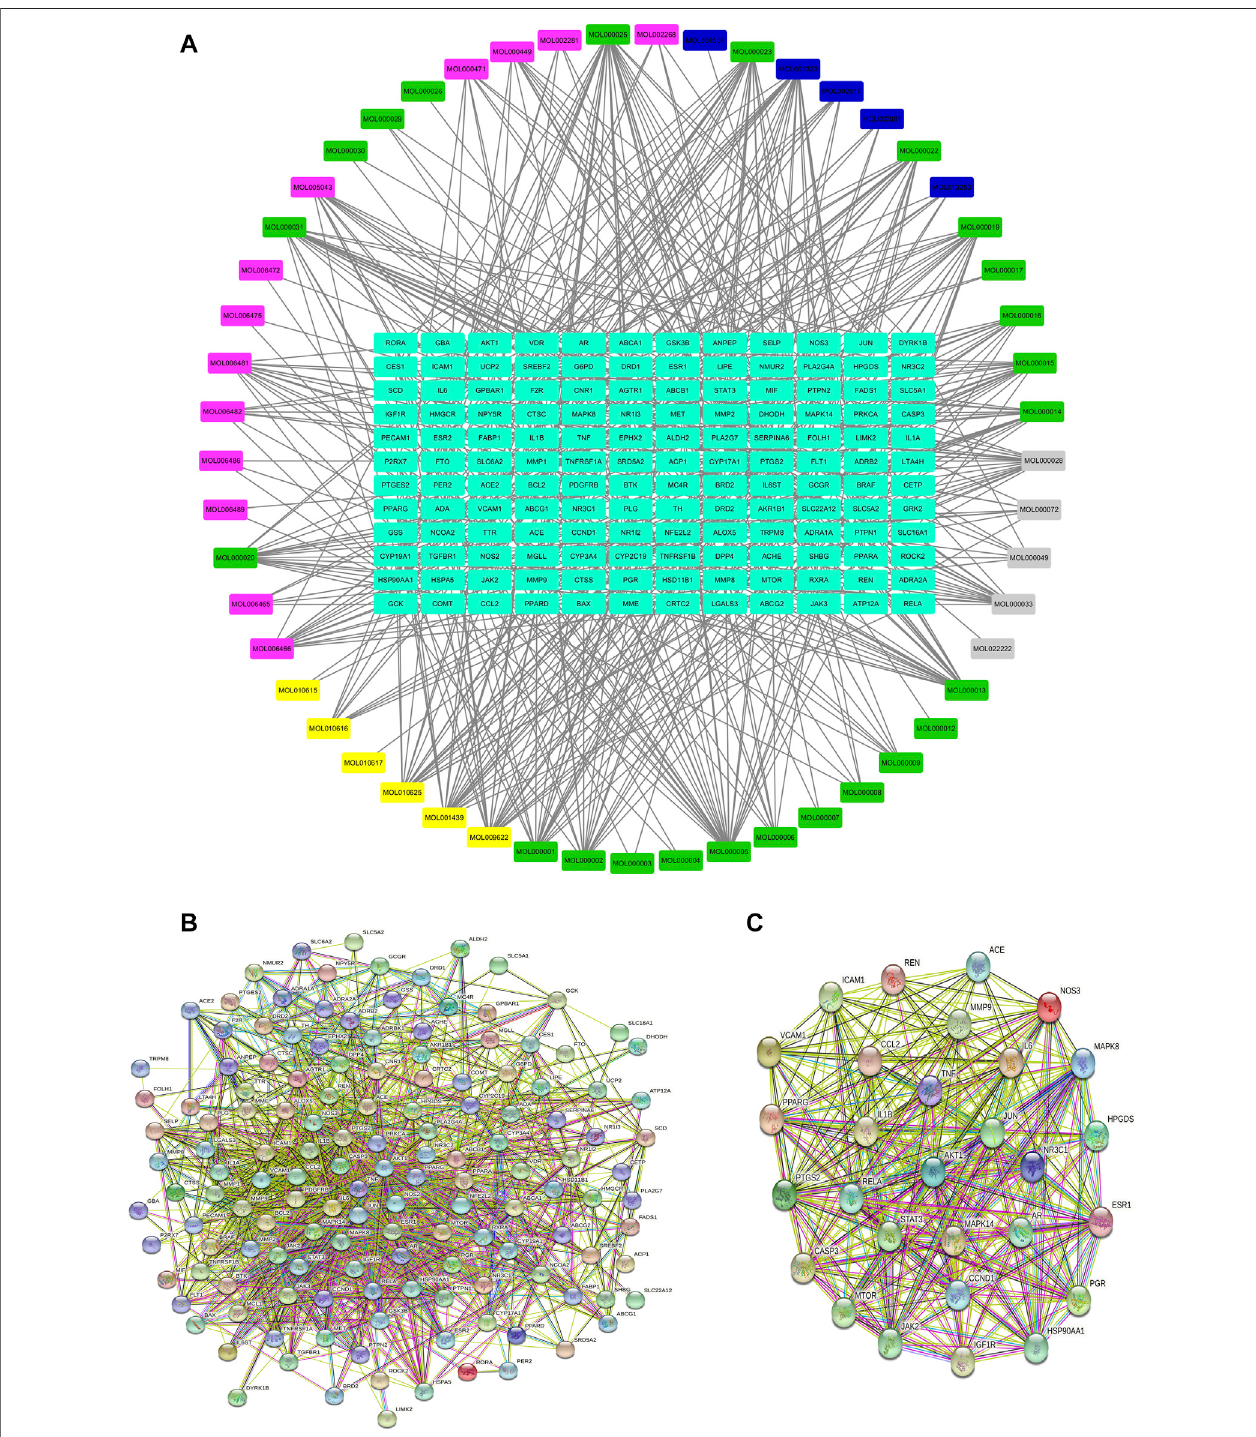
FIGURE 1 | Network pharmacology analysis of KD in the treatment of metabolic syndrome. (A) Compound-target network of KD. The network included 52 compoundsand 145proteins,and contained197nodesand 554edges. (B) PPInetworkoftheidenti fi edtargets. (C) ThehubtargetofKDinthetreatmentofmetabolic